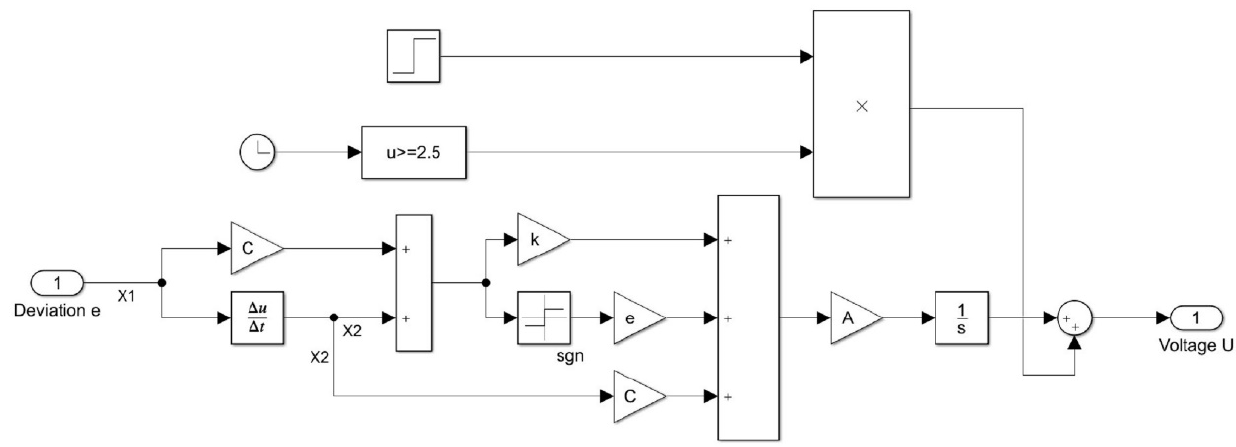
Figure 11. Simulink model of sliding mode control strategy.